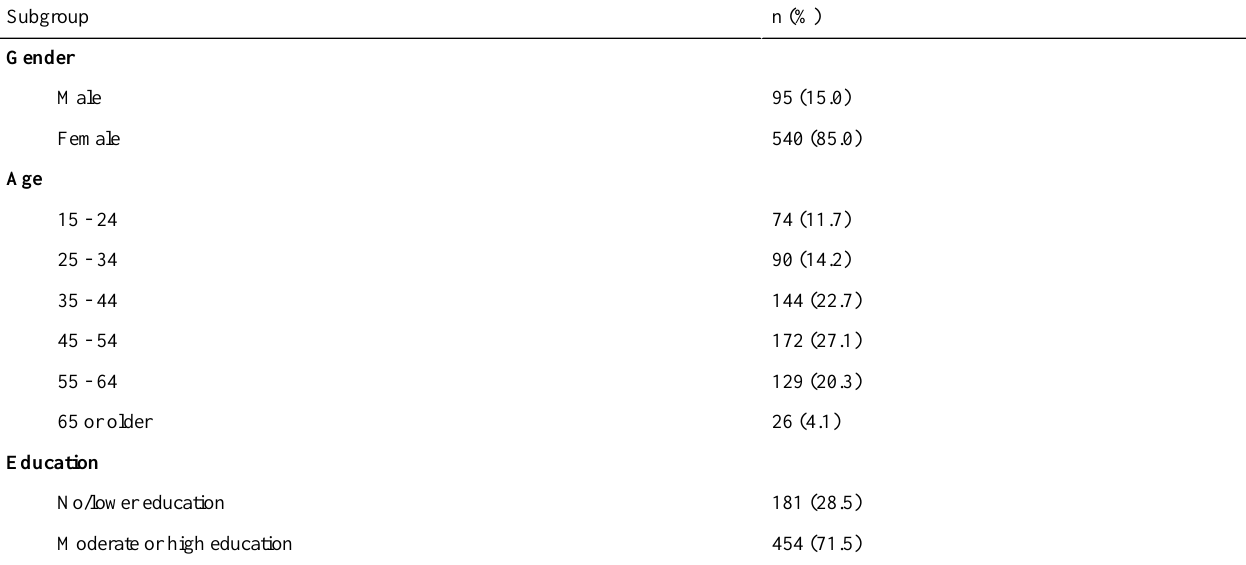
Table 1. Survey respondents (N=635).